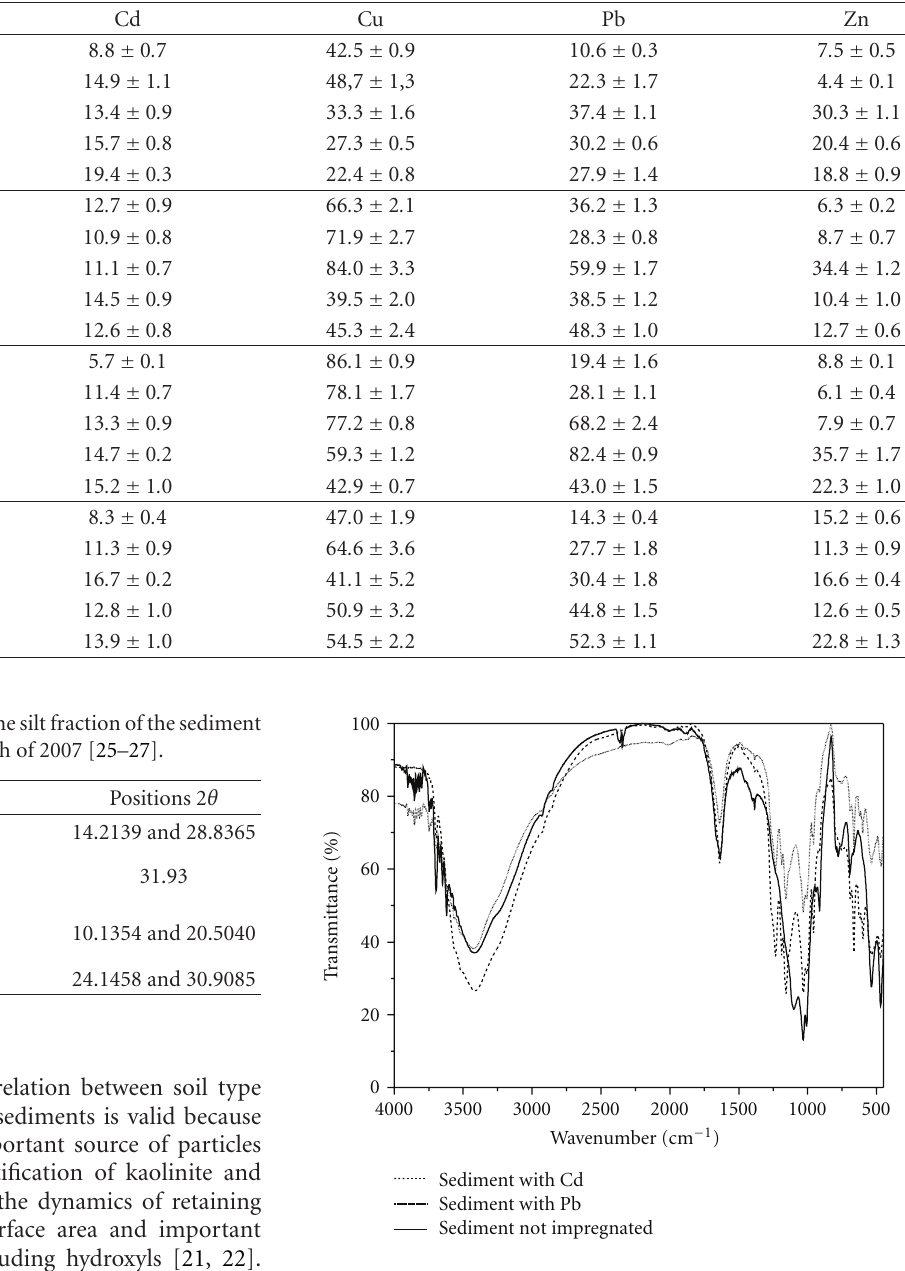
Table 5: Pseudototal concentrations of Cd, Cu, Pb, and Zn (mgkg − 1 ) in some sediment samples collected from the Jacu´ıpe River’s estuary, n = 5.